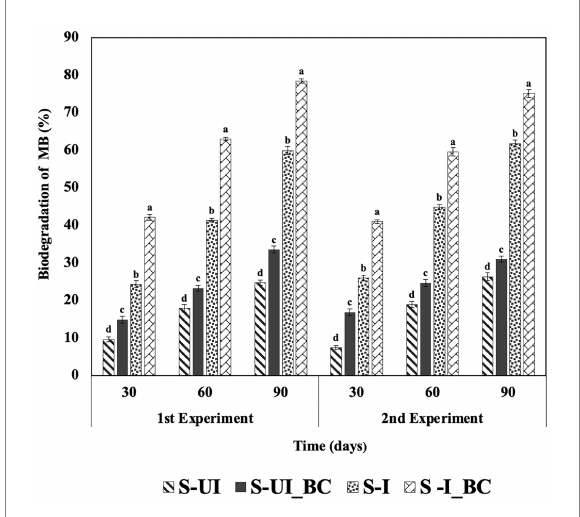
FIGURE 1 Biodegradation of metribuzin (MB) soil under various treatments at 30, 60 and 90 days after incubation (DAI) during two experiments. Initial MB concentration in the soil was 2.5 mg Kg − 1 and % degradation was calculated based on residual